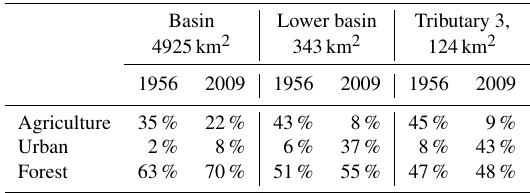
Table 2. Land use change in the whole lower basin and tributary 3 sub-basin in 1956–2009 (Prats-Puntí,